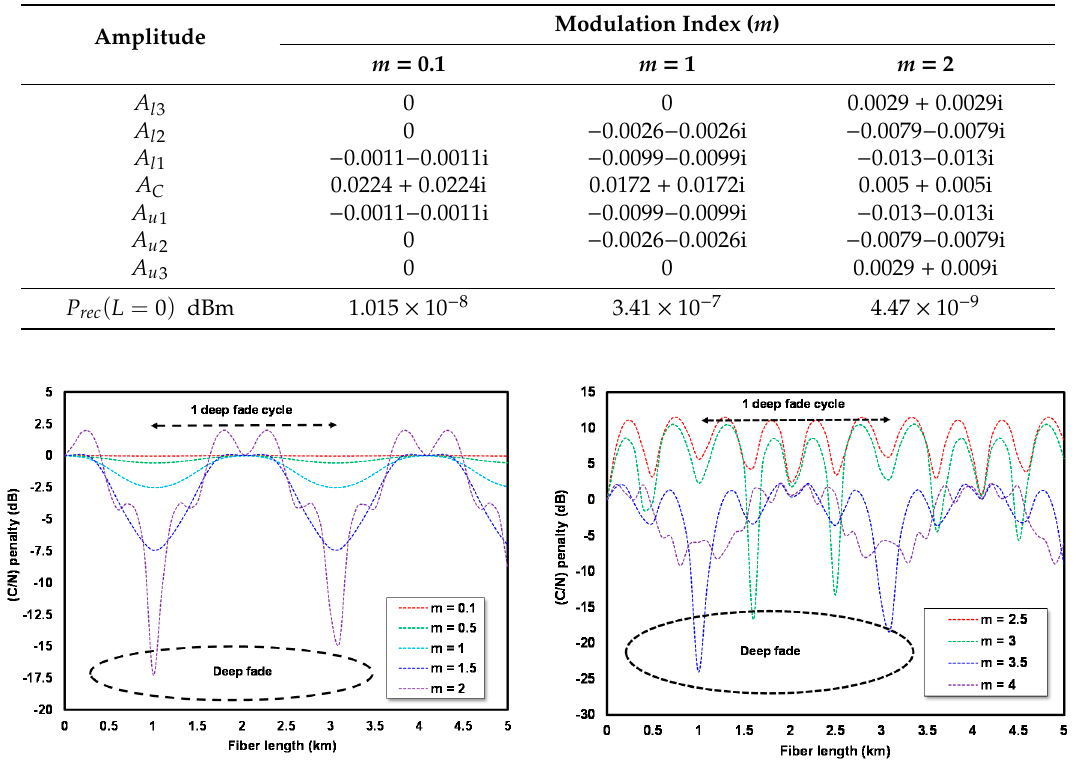
Table 2. Comparison value of the ∆ C / N Penalty and DF between the ODSB and OSSB